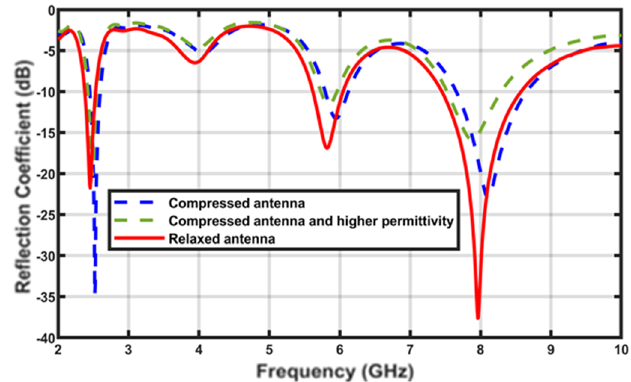
Figure 15. Compression analysis of the antenna by varying the thickness and permiivity.